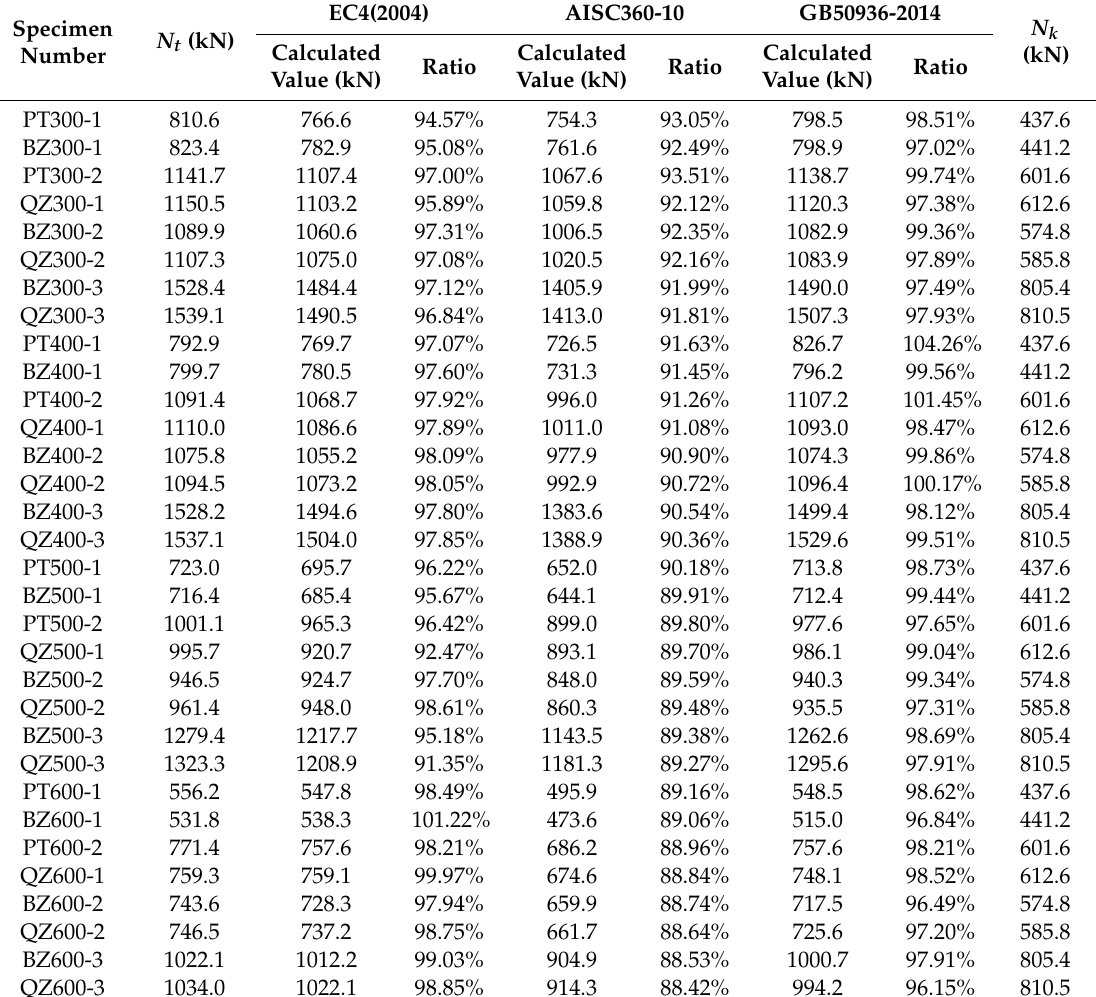
Table 4. Summary and comparison of test and calculated values of bearing